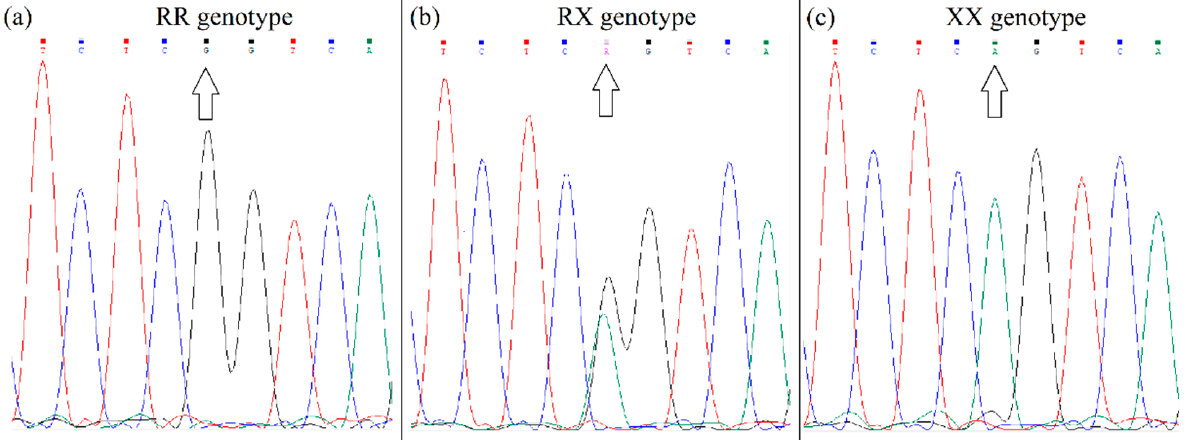
Figure 2. Fluorogram of ACTN3 gene sequencing. Figure ( a ) shows the genotype RR, since nucleotide G is located at the polymorphic site. Figure ( b ) shows the genotype RX, because the nucleotides G and A are located at the polymorphic site. Figure ( c ) shows the genotype XX, since nucleotide A is located at the polymorphic site.